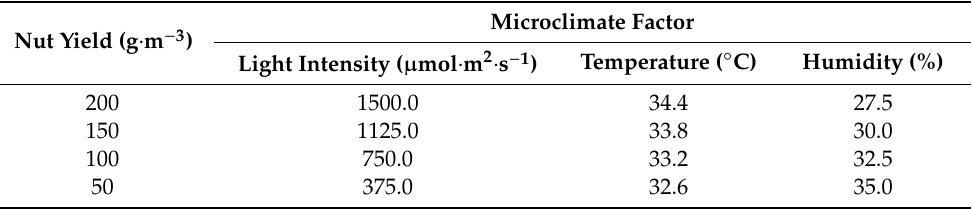
Table 3. Relationship between microclimatic factors and nut yield.